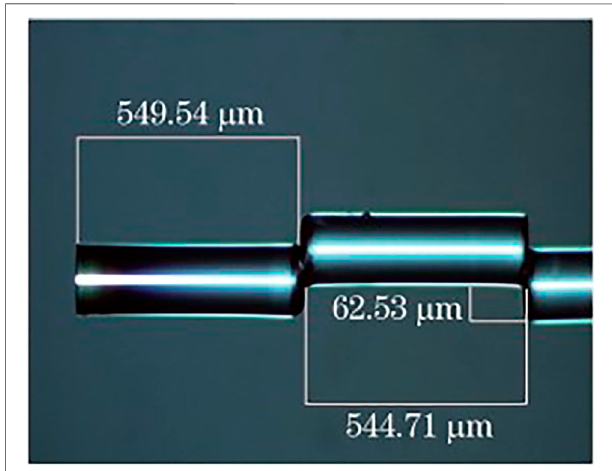
FIGURE 5 | Physical microscopic view of the sensor probe